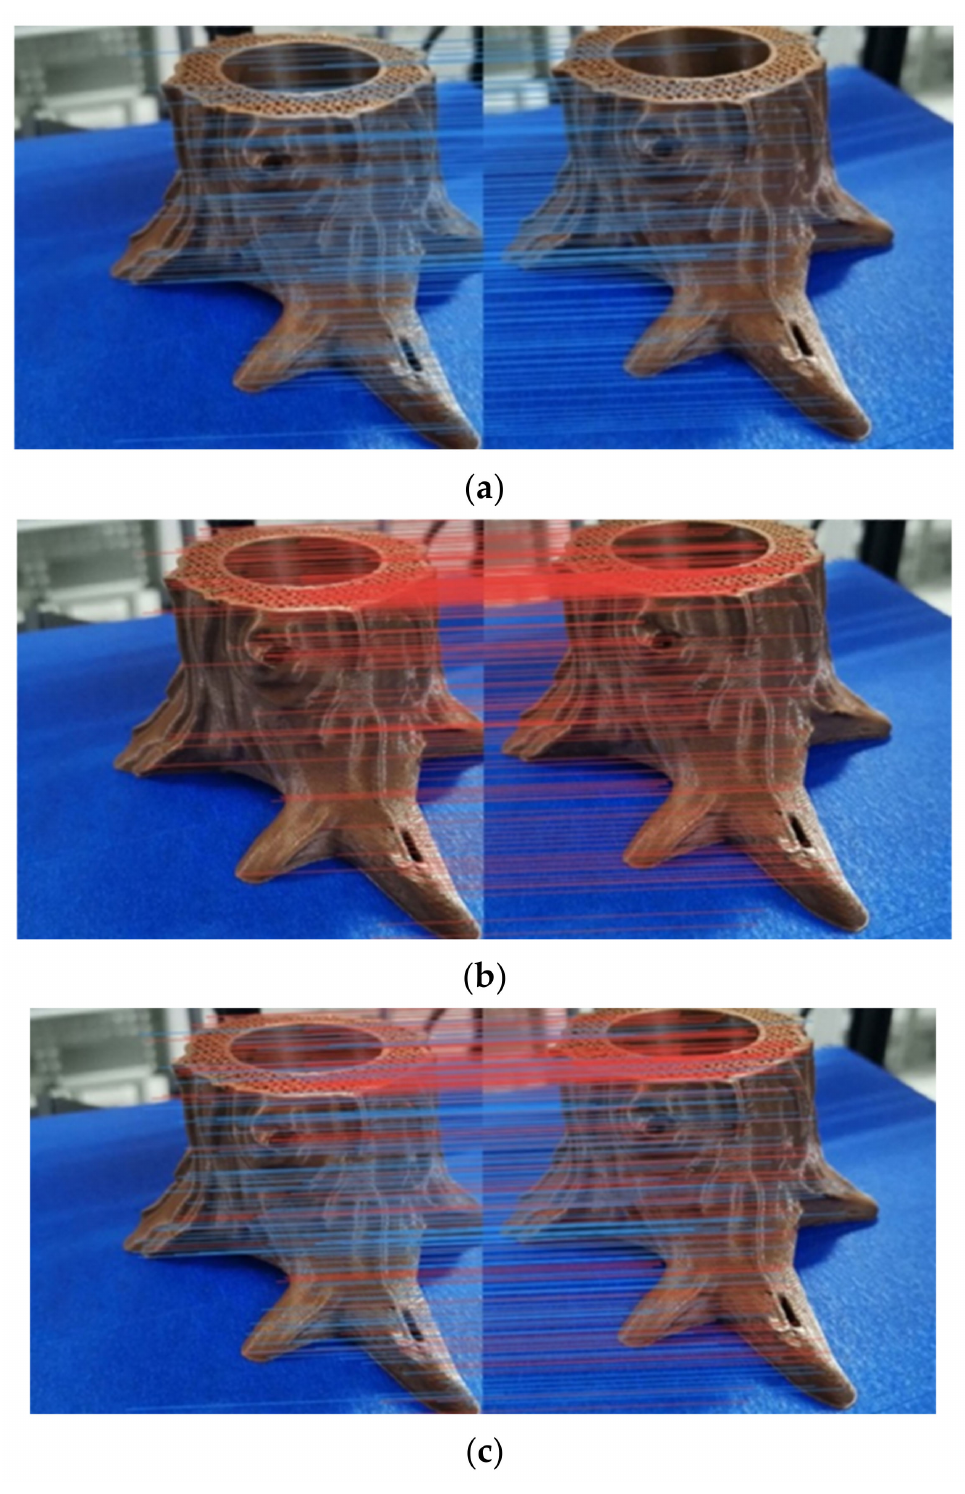
Figure 9. Feature point matching results based on three algorithms. ( a ) Feature points matching result based on the FFT-SIFT algorithm; ( b ) feature points matching result based on the AKAZE algorithm; and ( c ) feature points matching result based on the FFT-SIFT-AKAZE algorithm. The Table 3 respectively records the average number of feature points extracted, feature points extraction time, feature points matching time and the number of final feature points matching based on the FFT-SIFT algorithm, AKAZE algorithm and FFT-SIFT-AKAZE algorithm in the actual printing process. Figure 10 shows the 3D reconstruction